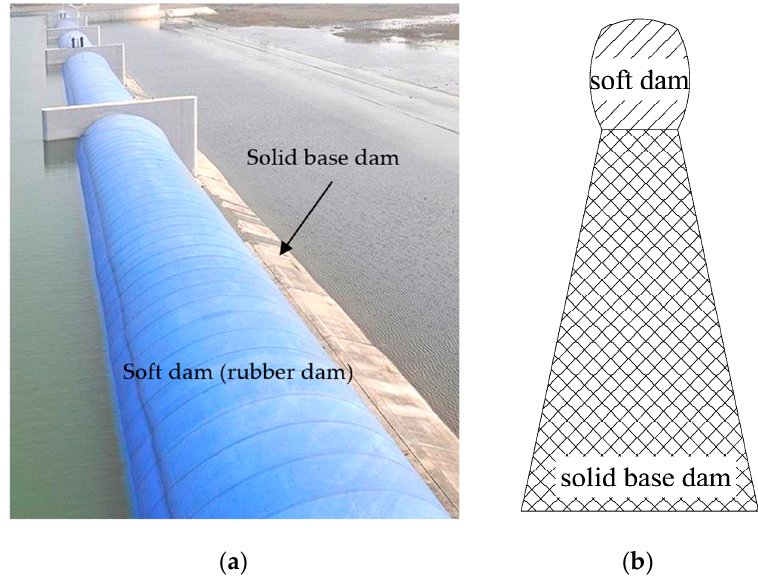
Figure 12. The schematic of the combined dike for IFCS. ( a ) The water block by the combined dike; ( b ) sections of the dike.